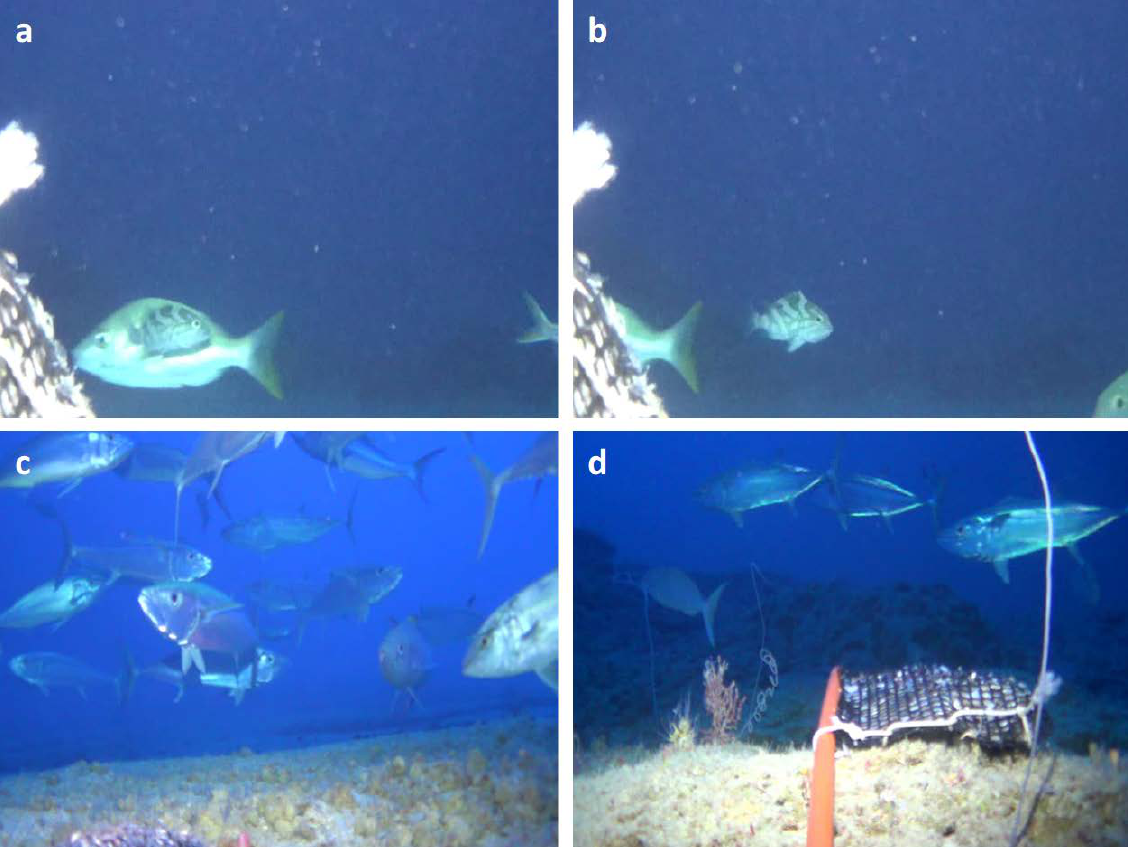
Figure 10. Some deep Baited Remote Underwater Video Stations captured juvenile fishes, including this Epinephelus morrhua at 194 m ( a,b ). Another deployment captured a large aggregation of Gymnosarda unicolor and other species ( c ). Most often G. unicolor were found in small groups of one to three individuals ( d ).